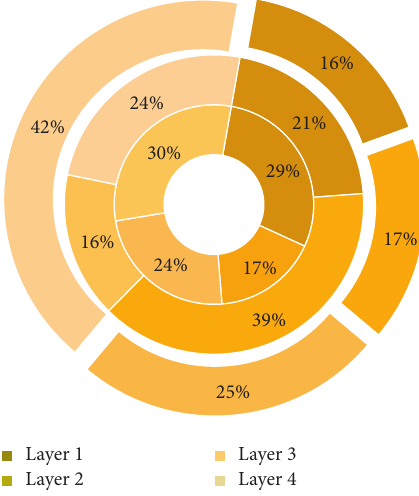
Figure 6: Distribution of graduate employment information